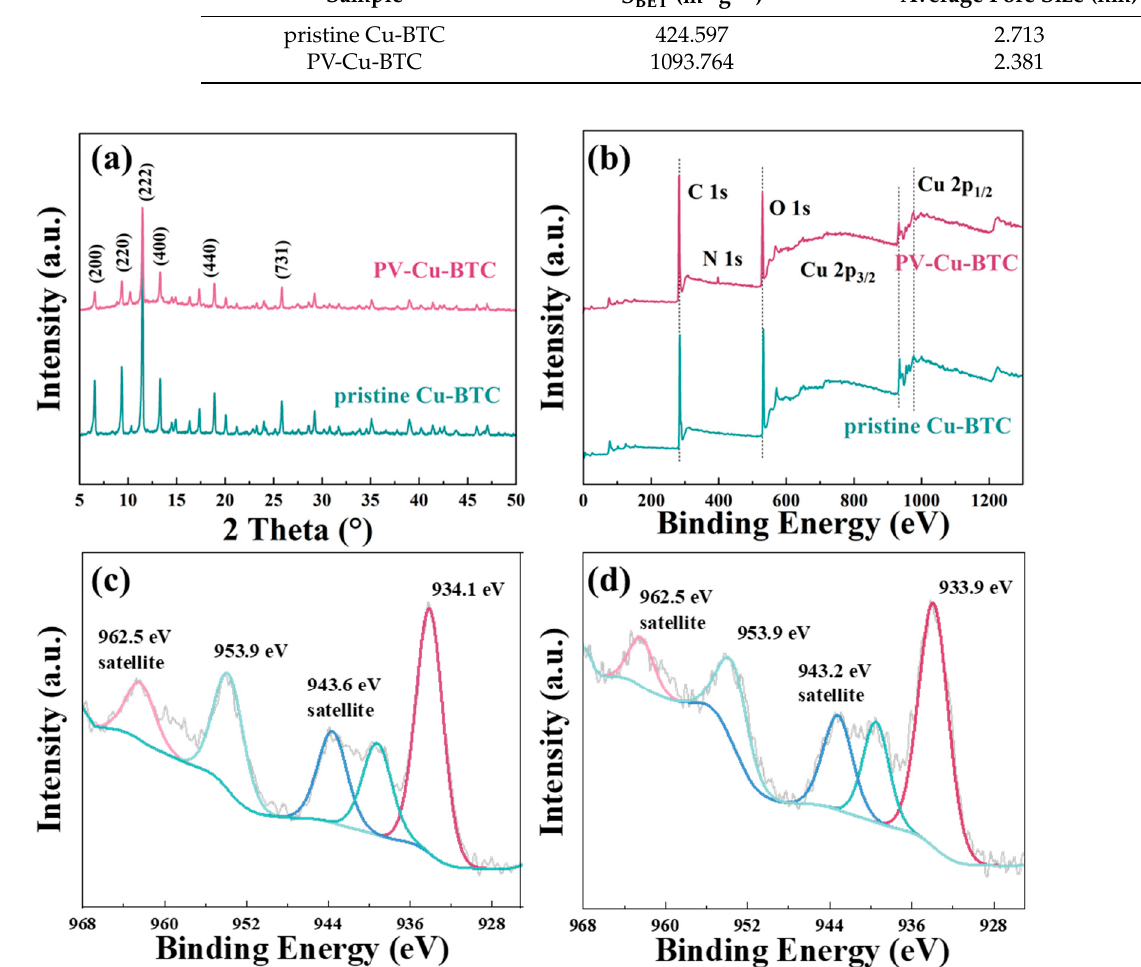
Figure 5. XRD patterns of Cu-BTC ( a ), survey XPS ( b ), Cu 2p XPS of pristine Cu-BTC ( c ) and Cu 2p XPS of PV-Cu-BTC ( d ).